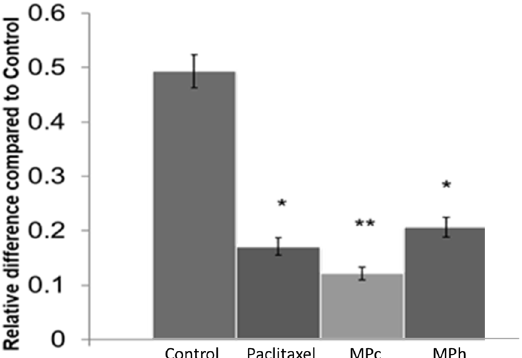
Figure 8. Effect of extracts on PC3 cells using the CytoSelect invasion assay (cells treated with the MNTC concentration of MPc and MPh for 48 h). The results shown are representatives of three independent experiments. Data are means ± SEMs ( n = 3). * p < 0.05 and ** p < 0.01, as determined via unpaired t -test.